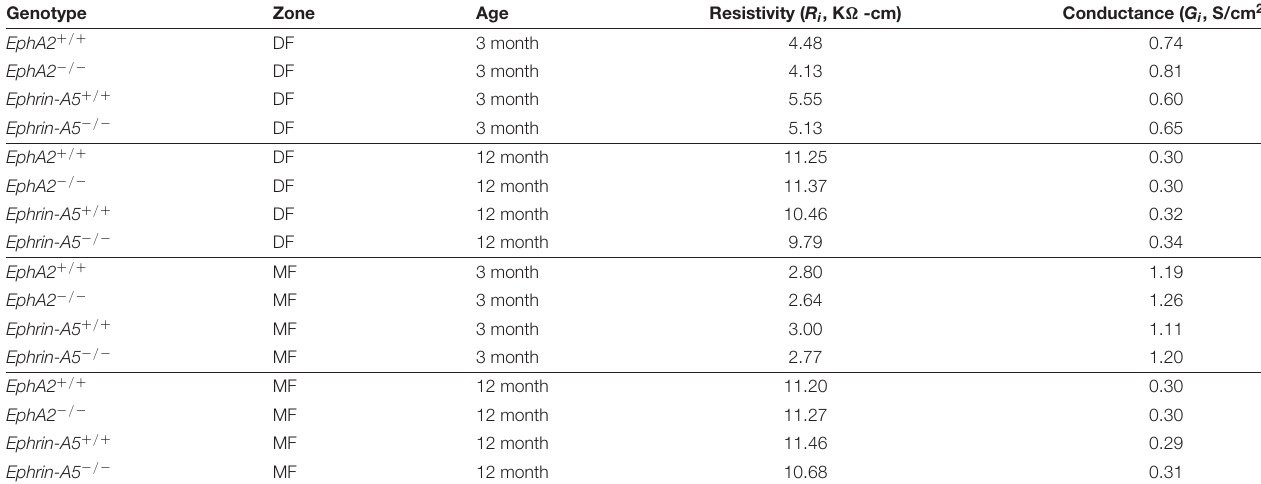
TABLE 1 | Regional values of resistivity ( R i ) and normalized coupling conductance ( G i ) of four types of lenses at two ages in differentiating fibers (DF) and mature fibers (MF). Genotype Zone Age Resistivity ( R i , K (cid:127) -cm) Conductance ( G i , S/cm 2